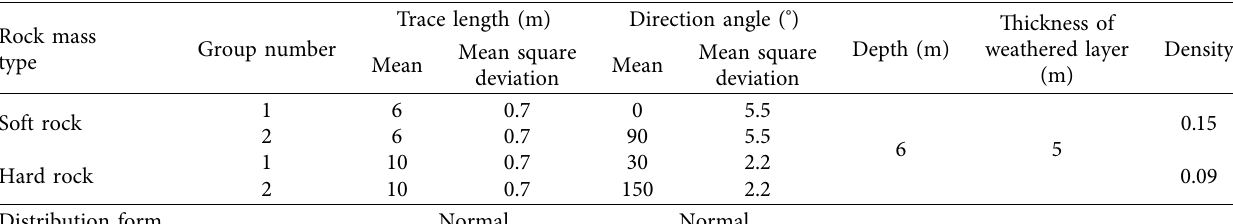
Table 3: Distribution characteristics of multiple joint